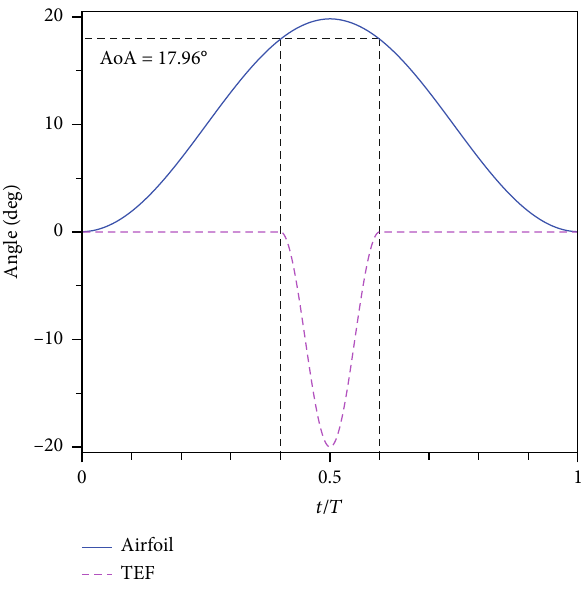
Figure 8: Motion pro fi les of the airfoil and the TEF.